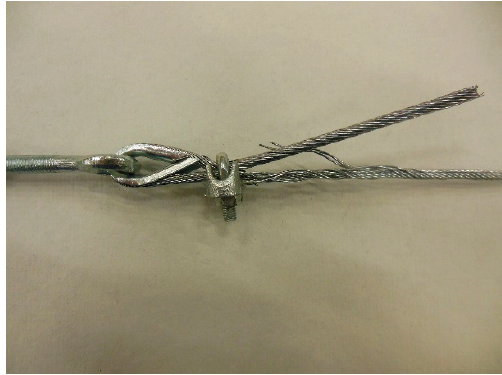
Figure 34. Failure mechanism of Specimen 3. Materials 2019 , 12 , x FOR PEER REVIEW